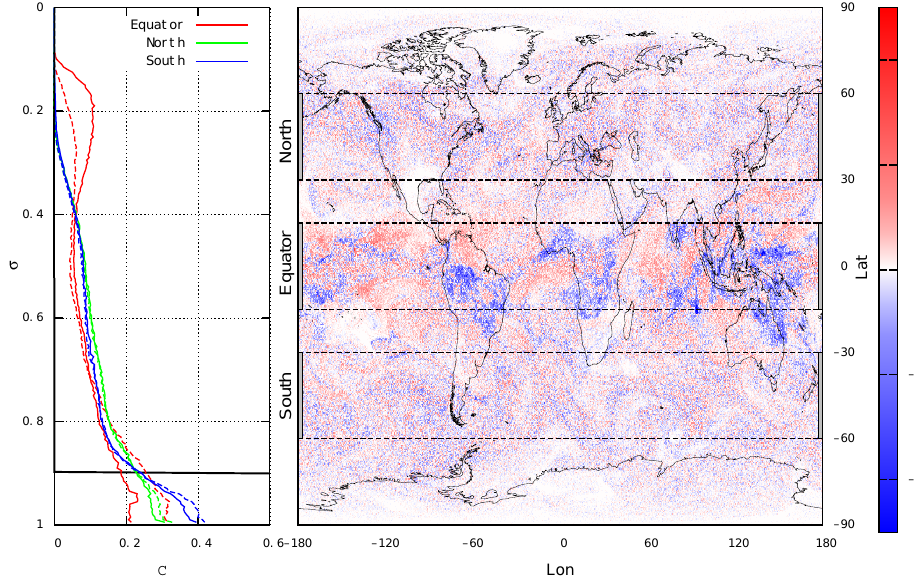
Figure 5. Left: vertical concentration profiles (in arbitrary units), as function of σ . Colours and line-types have the same meaning as in Fig. 4. In addition, the top of the release region ( σ = 0 . 9), is displayed as a bold solid line. Right: difference map (with convection minus without convection) of vertically integrated particle number at the end of the simulation for all the three emission subdomains (initial emission area as labelled in the figure: north, Equator, south). Details on the concentration normalizations for both panels can be found in Sect.